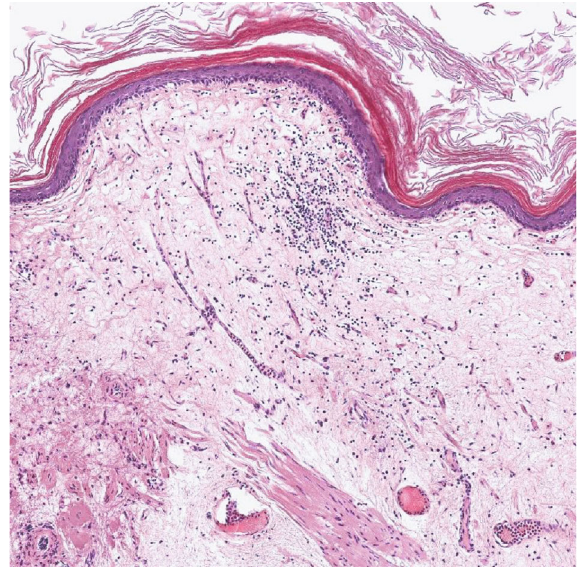
Figure 6: Loose subepithelial connective tissue rich in small vessels with chronic in fl ammation in fi ltrate.